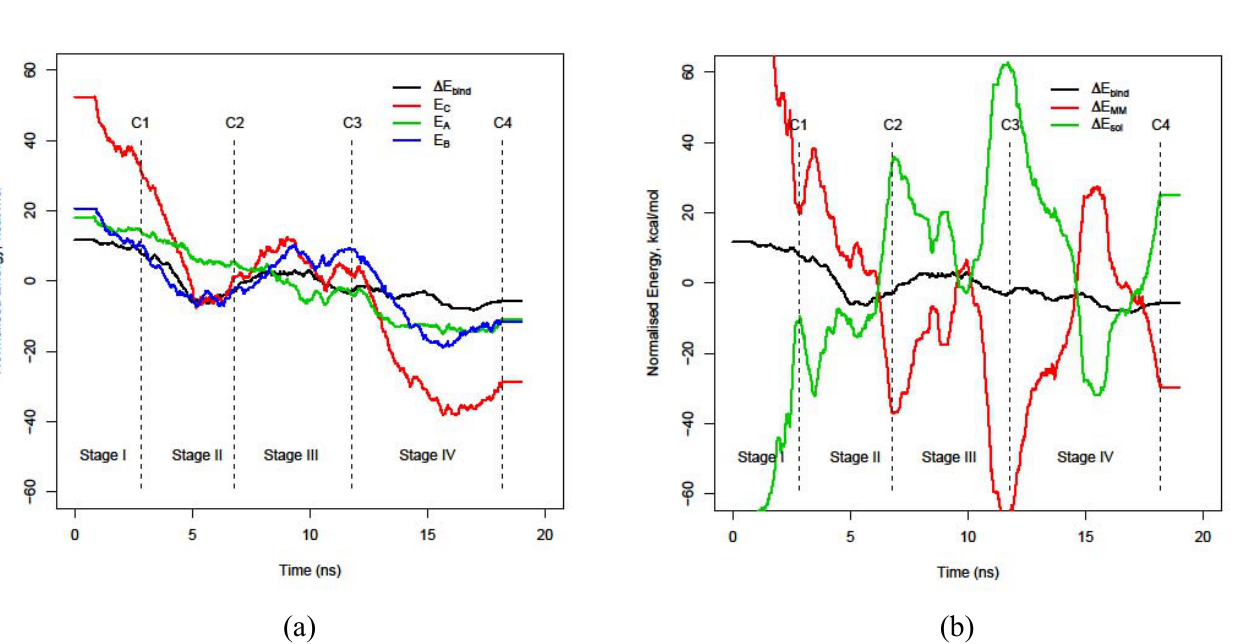
Figure 1. Evolution of Δ E Δ E = Δ E + Δ E . bind MM sol